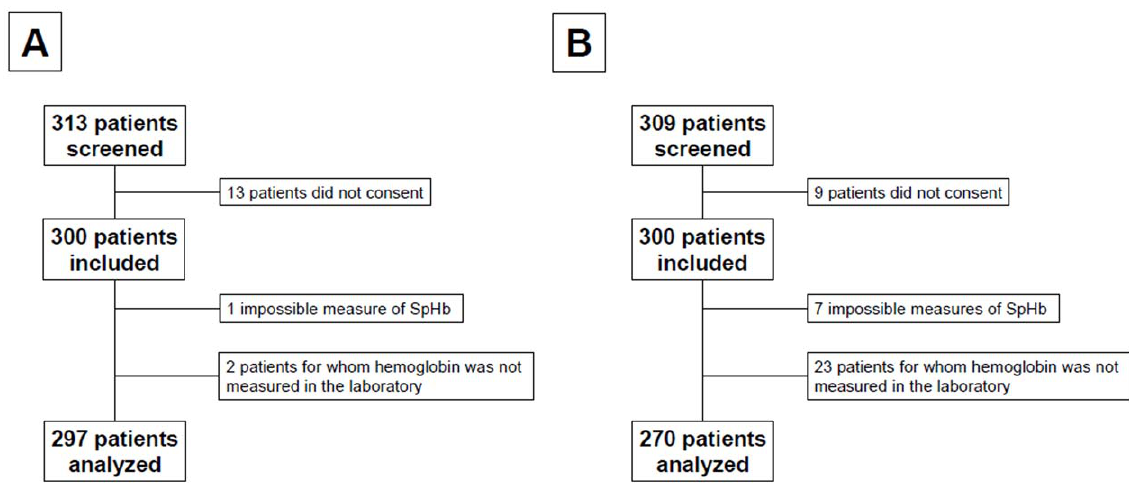
Figure 1. Flow chart of the studies (Pronto-7 TM on panel A and Orsense on panel B).